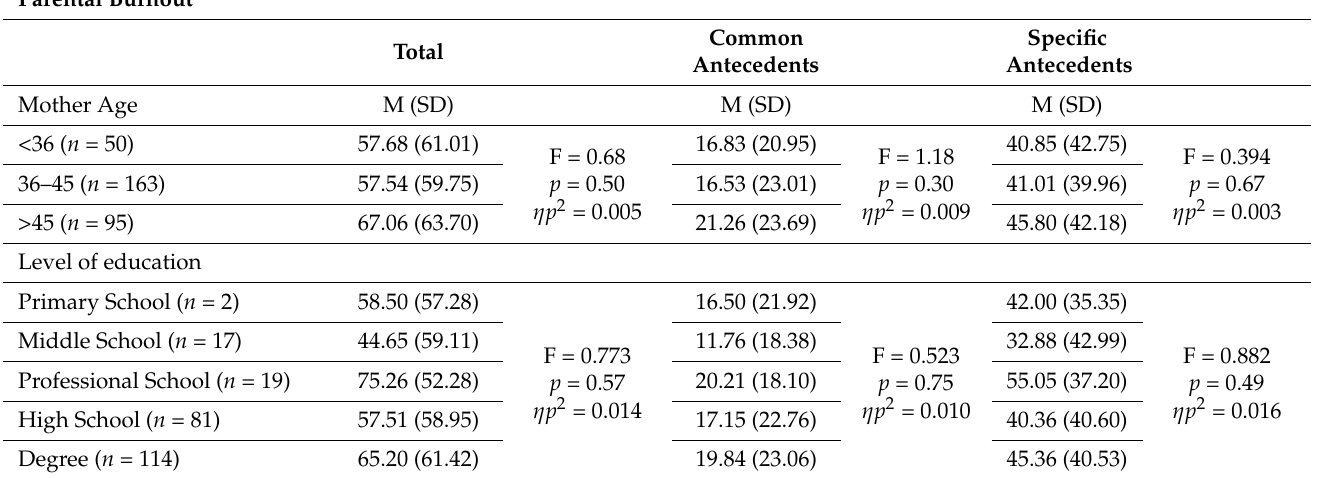
Table 2. Means, standard deviations, and ANOVAs of the dependent variables (mother age, level of education, work regimen during the first Lockdown for COVID-19, child age, child sex and child atypical development) for the dependent variable parental